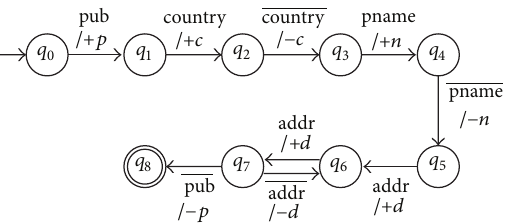
Figure 6: VPA 𝑆 2 expressing information about publishers.